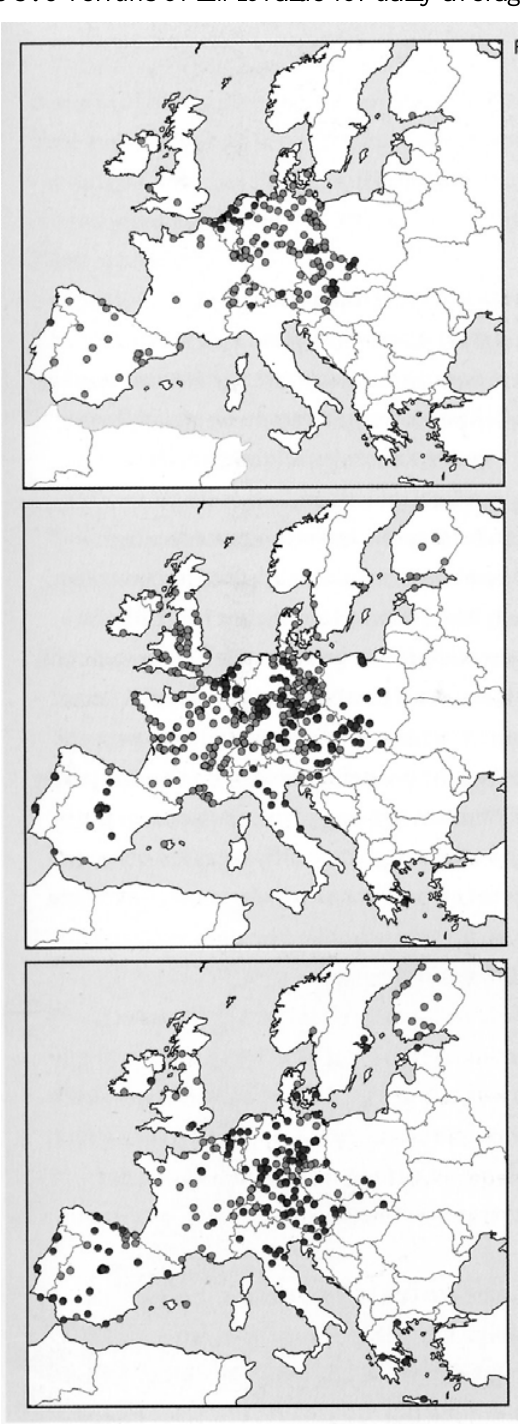
Figure 3. Overruns of limit value for daily average PM